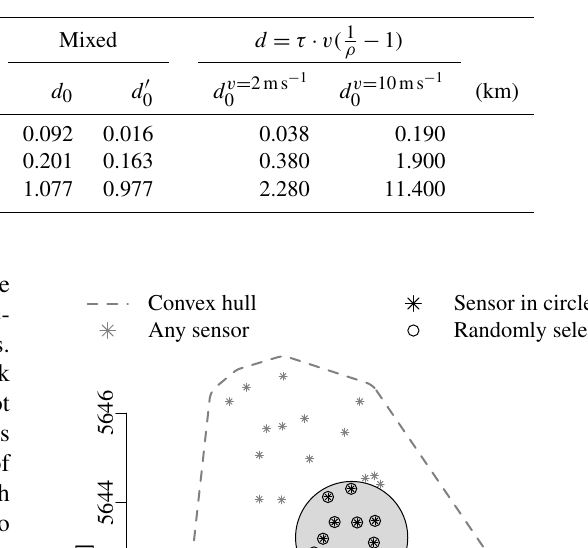
are obtained from the generalized analysis in said figure’s panels j–l. 0